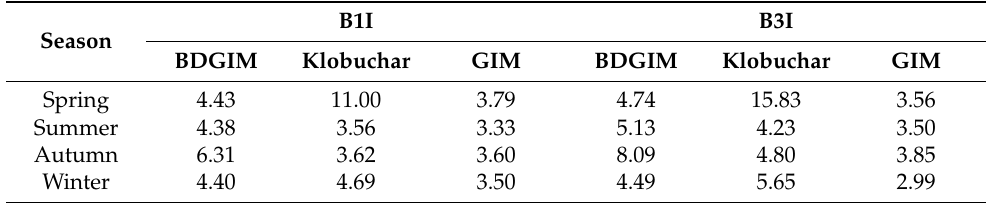
Table 7. The average 3D positioning accuracies of different models for old BDS signals in different seasons (unit: m).